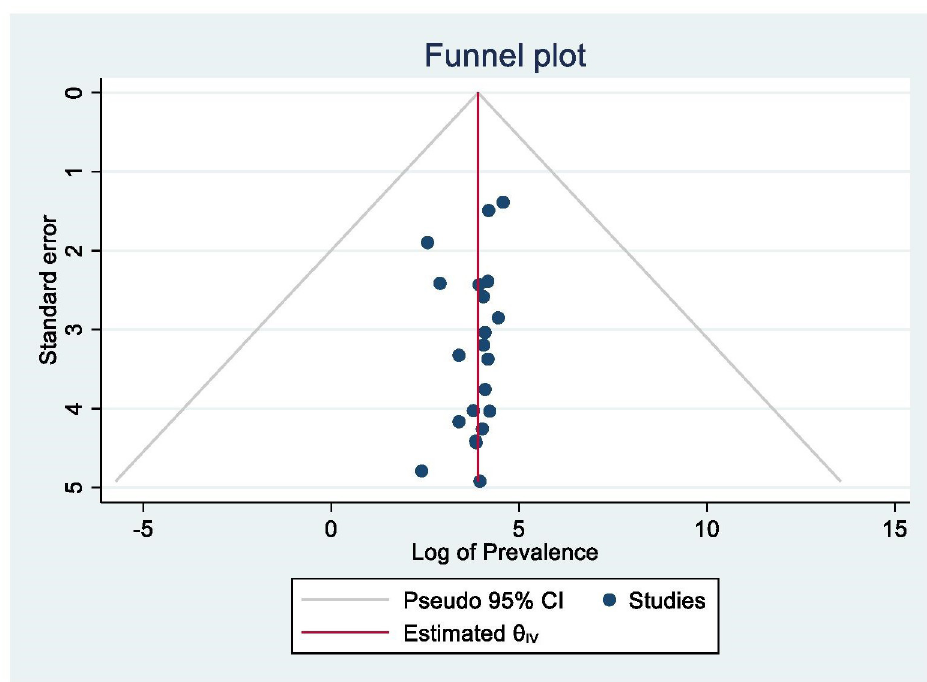
Fig 3. Funnel plot to test the publication bias of the 21 studies.